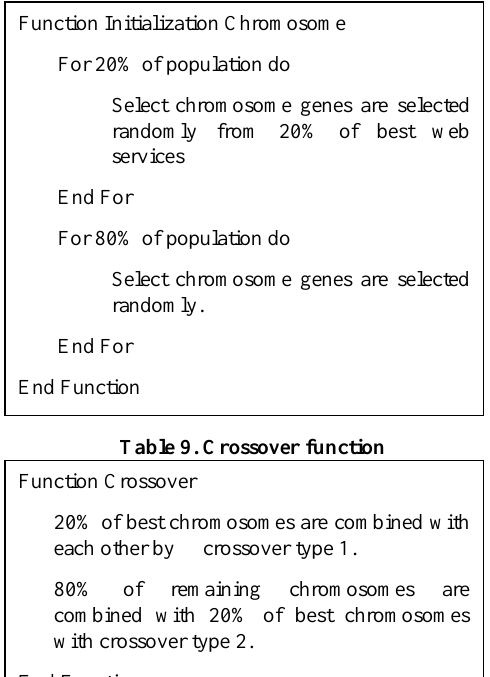
Table 9. Crossover function